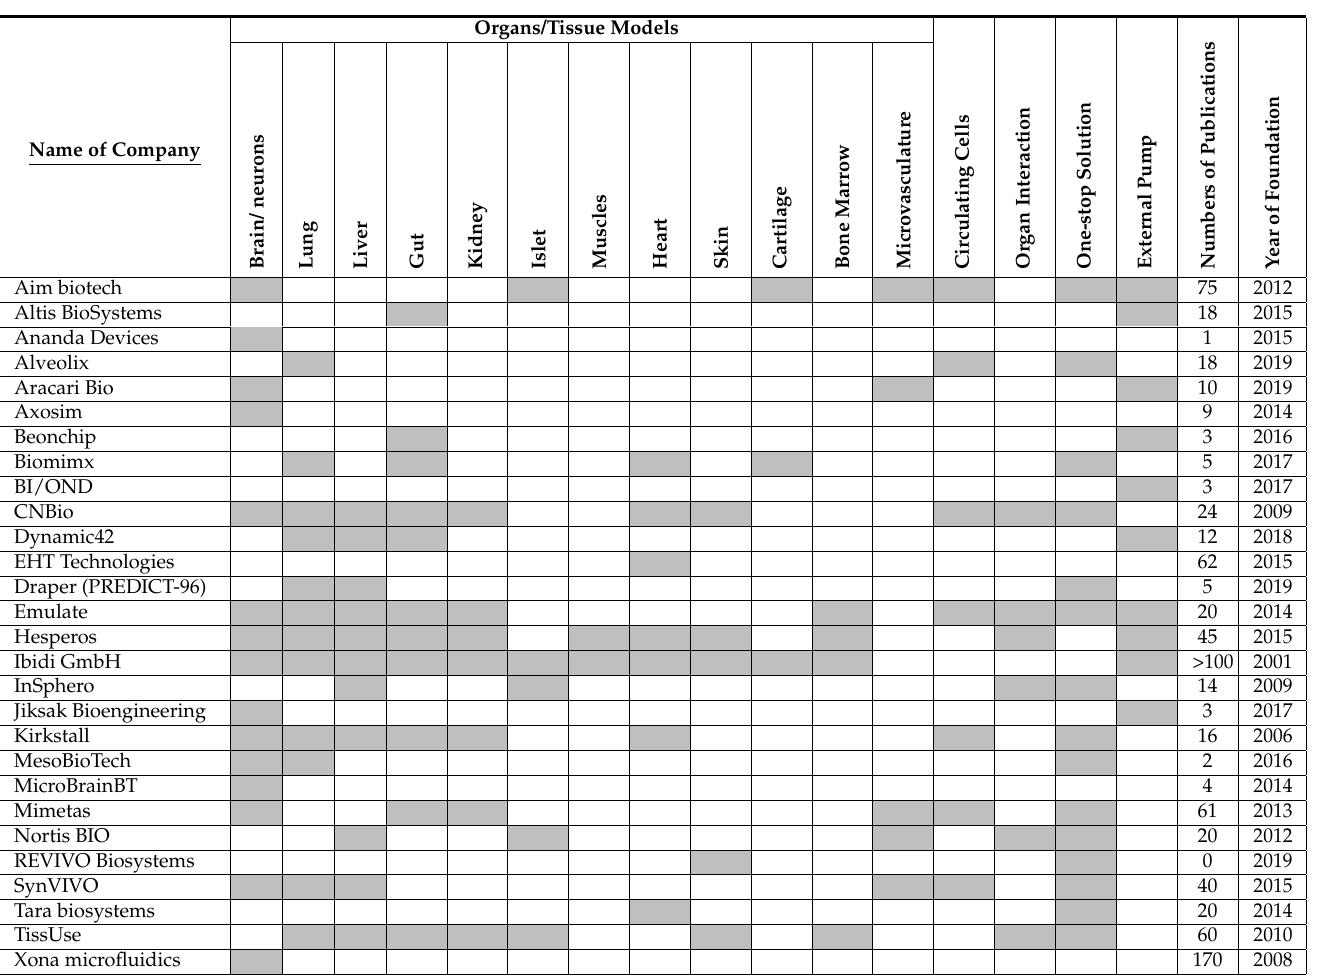
Table 1. Overview of OoC